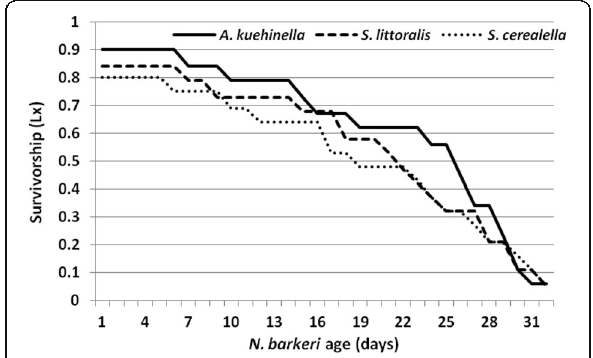
Fig. 1 Age-specific survivorship of Neoseiulus barkeri fed eggs of Anagasta kuehniella , Spodoptera littoralis , and Sitotroga cerealella and incubated at 27 °C and 65% RH